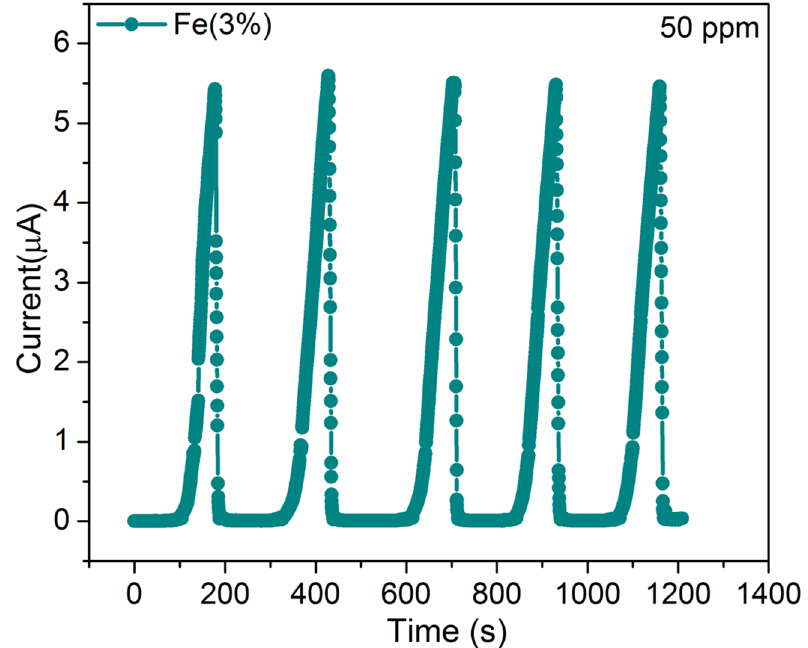
Figure 8. Cycle test of MoO 3 :Fe(3%) thin film.